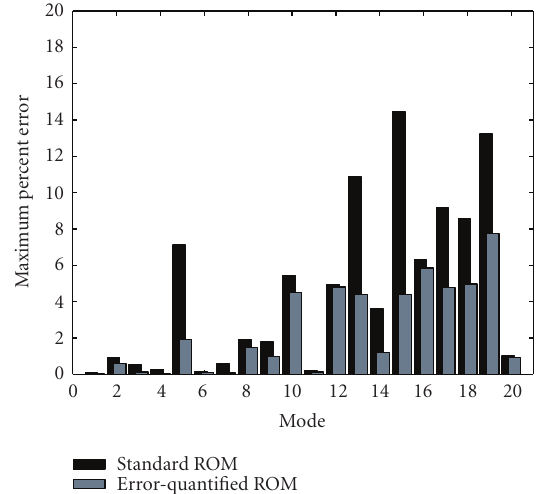
Figure 14: Maximum error calculation for airfoil forced